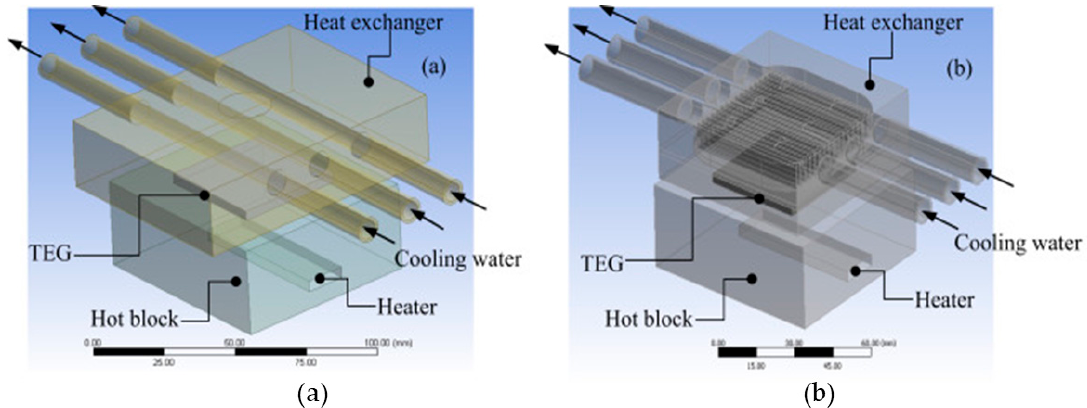
Figure 10. ( a ) Tube heat exchanger; ( b ) fin heat exchanger